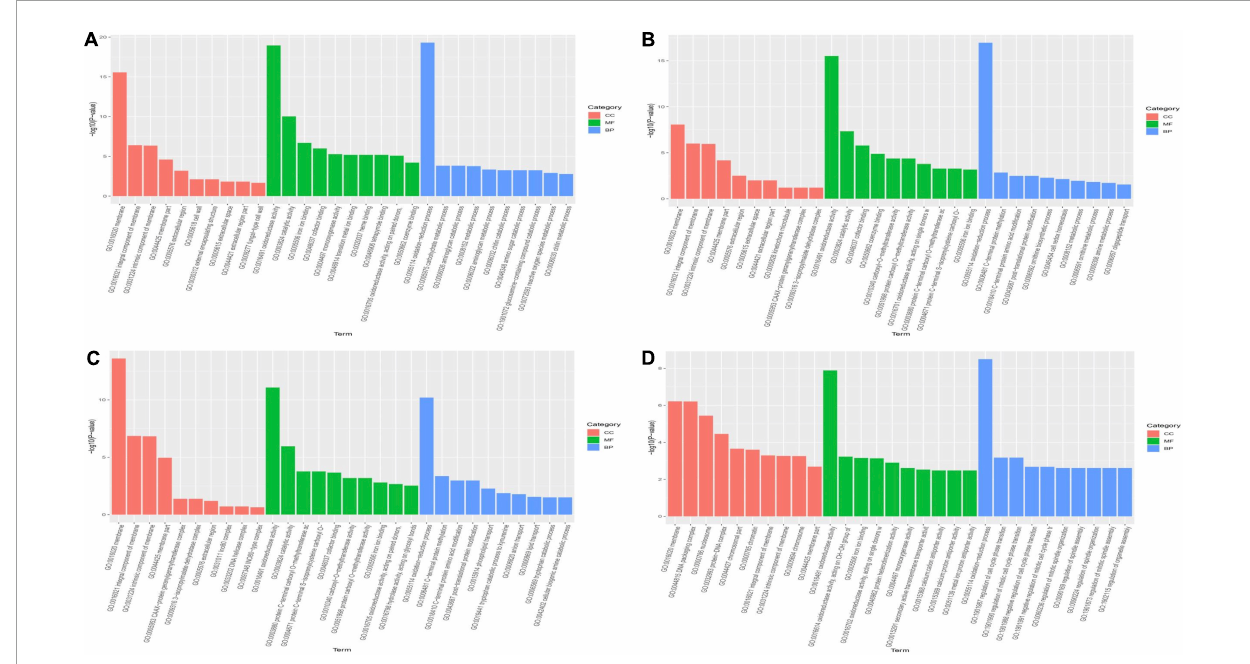
FIGURE3 Gene ontology (GO) enrichment analysis of differentially expressed genes in each group. The Y -axis represents the -log10 ( p -value) and X -axis represents the GO functional classification based on biological process, cellular component, and molecular function. (A) 30P_110P, (B) 50P_110P, (C) 70P_110P, (D) 90P_110P. BP, biological processes; CC, cellular components; MF, molecular